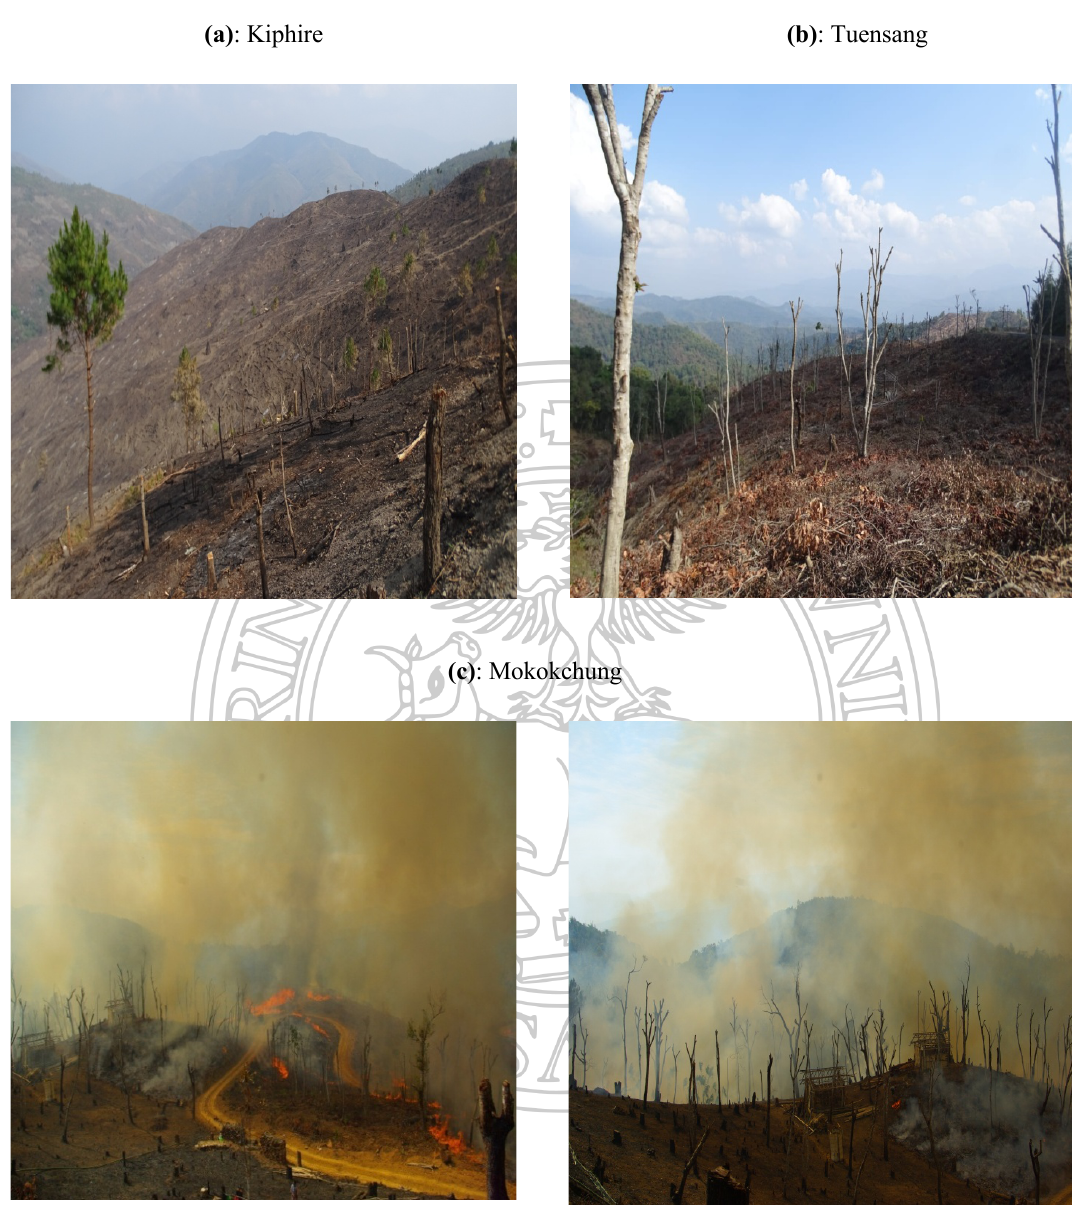
Figure 5 : Deforestation in different part of Nagaland for Jhum cultivation (a) : Kiphire (b) : Tuensang